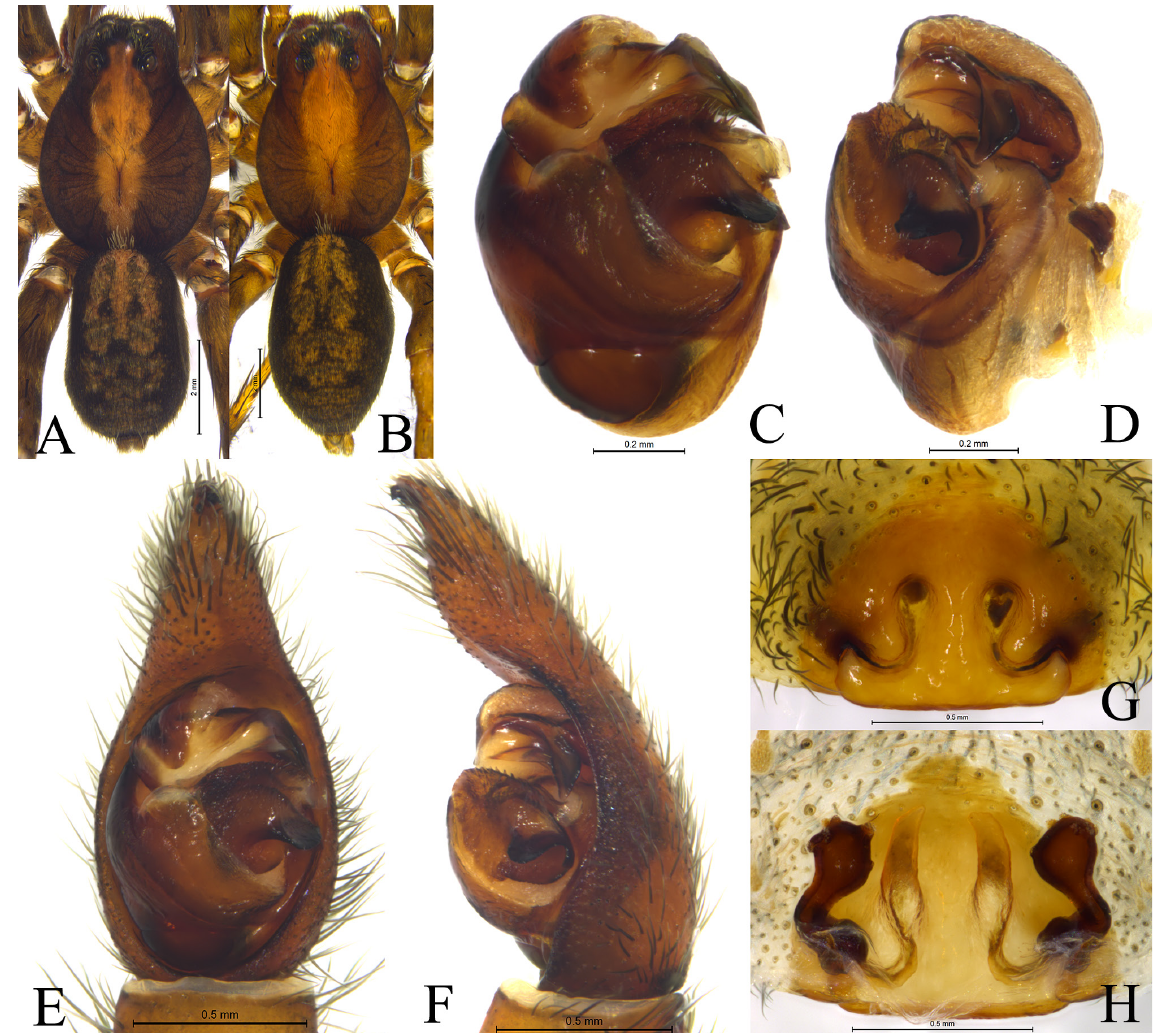
Fig. 3. Serratacosa medogensis gen. et sp. nov. A, E–F . Holotype, ♂ (SWUC-T-LY-12-01). B